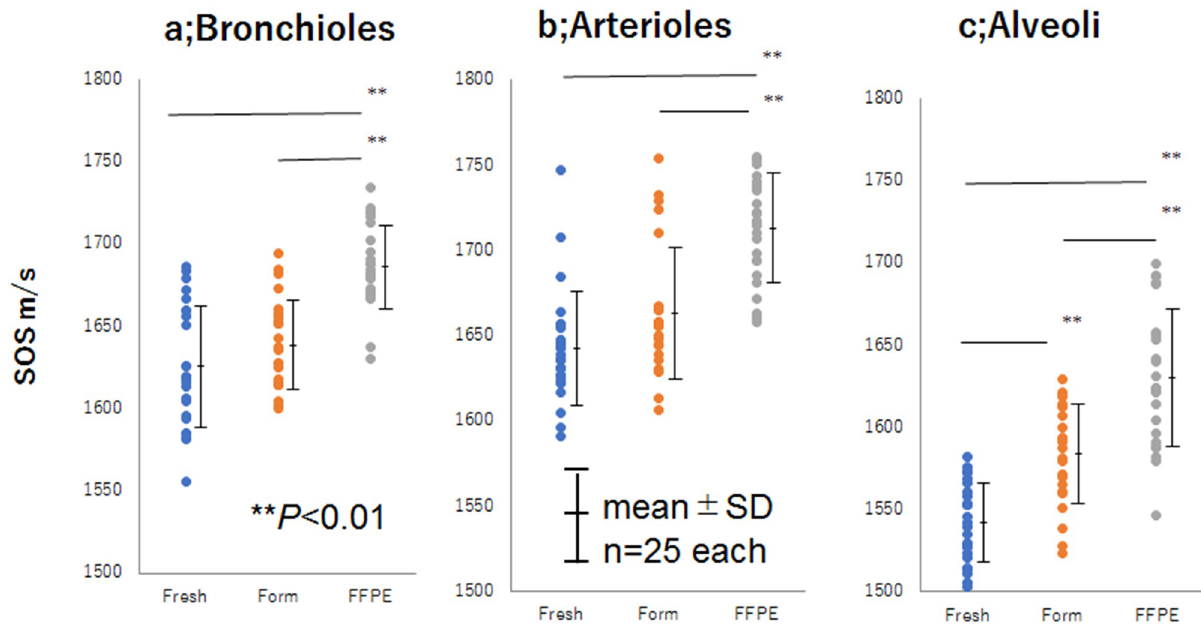
Fig 2. Dot plots of SOS values among different fixation methods. (a) Bronchioles, (b) arterioles, and (c) alveoli. Mean SOS values ( ± standard deviation) of bronchioles, arterioles, and alveoli were plotted to compare fixation and embedding effects. The FFPE sections exhibit significantly higher SOS values than fresh and formalin-fixed sections ( p <